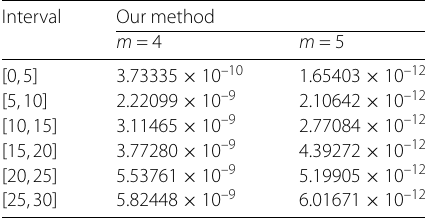
Table 3 Err of the proposed method for equations (23)–(24) with h = 0.1 Interval Our method m = 4 m = 5